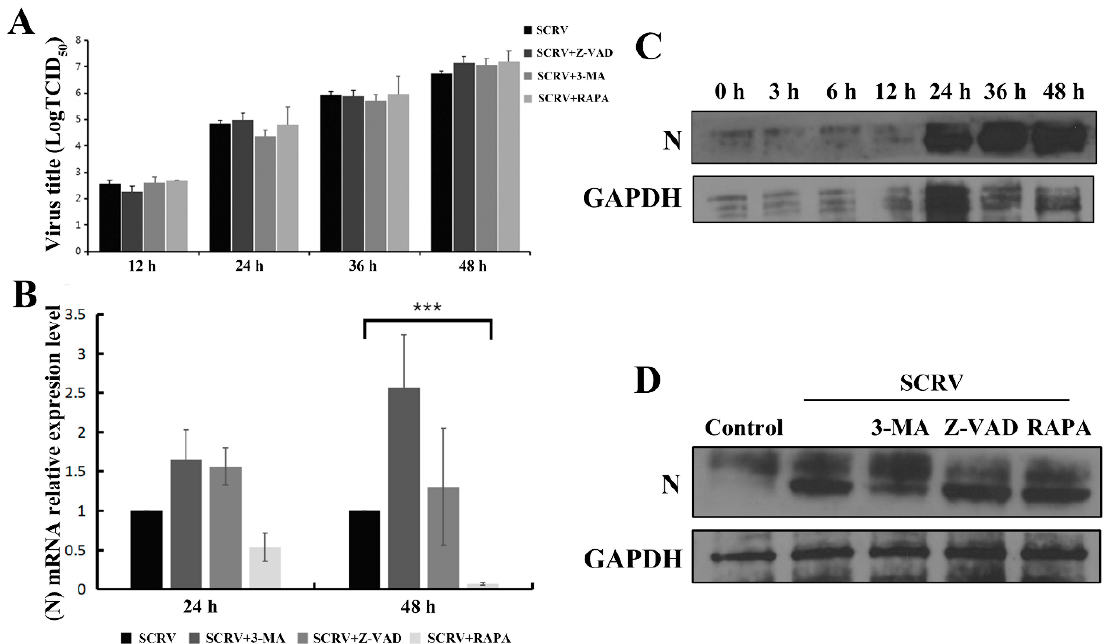
Figure 5. CPE observation of SCRV-infected EPC cells after co-incubation with different chemical (3-MA, Z-VAD and RAPA). Rapamycin could postpone the progress of CPE induced by SCRV at different time points. (Original magnifica- tion, ×100).